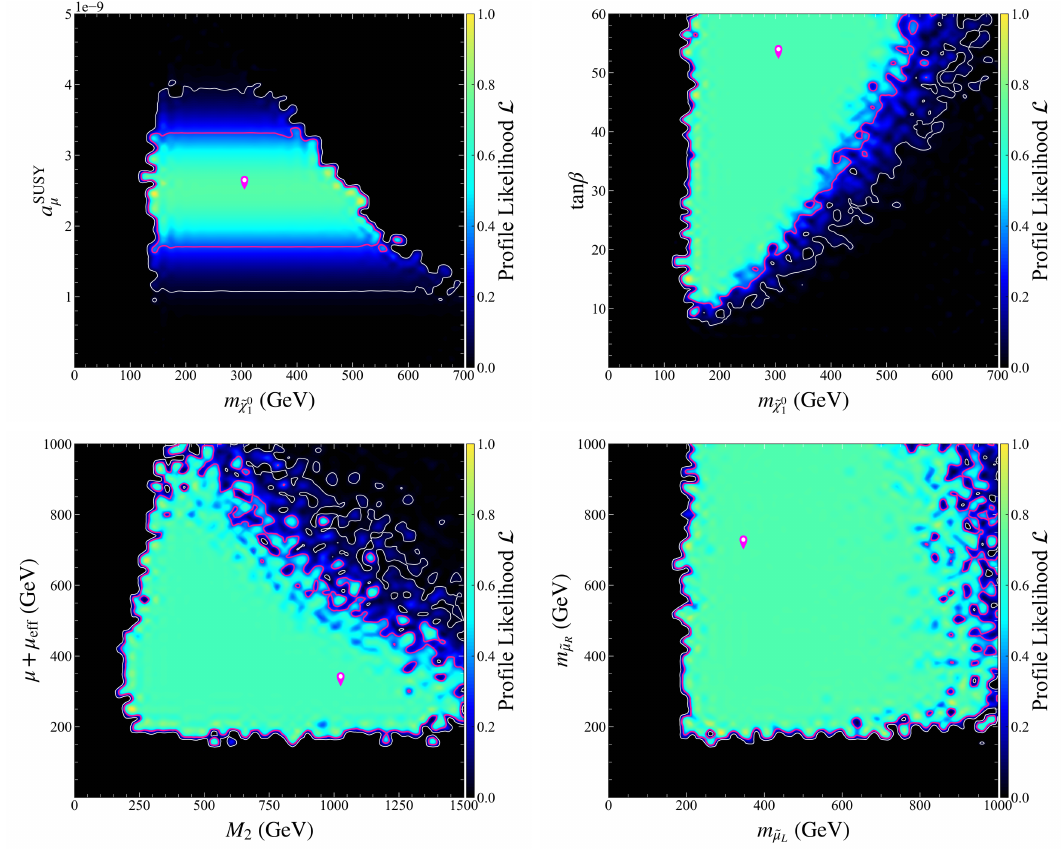
Figure 1 . Two-dimensional profile likelihood map of the function in eq. (3.2) projected onto , m m − a SUSY − tan β , M 2 − ( µ + µ eff ) , and m ˜ µ ˜ χ 0 1 ˜ χ 0 1 µ shown by pink (white) contour lines. The best point locates at m M 2 ’ 1050 GeV , m ˜ µ ’ 350 GeV , and m ˜ µ L value defined in section 4 is about